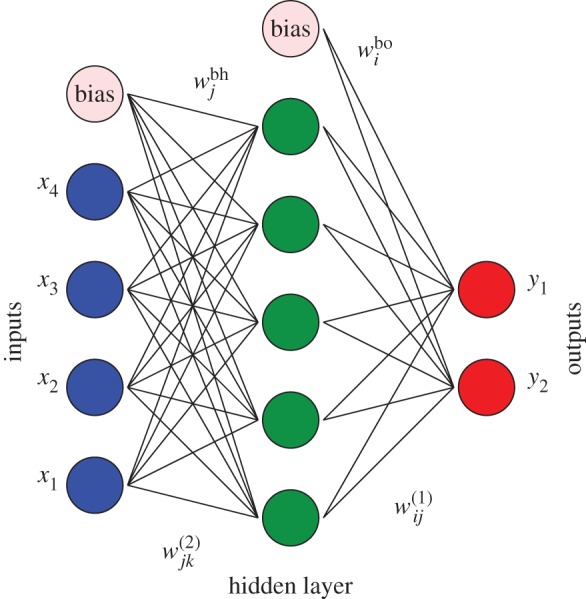
A three-layer neural network with four inputs, five hidden nodes and two outputs. The training variables are the link weights, wjk(2) and wij(1), and the bias weights, wbhj and wboi.